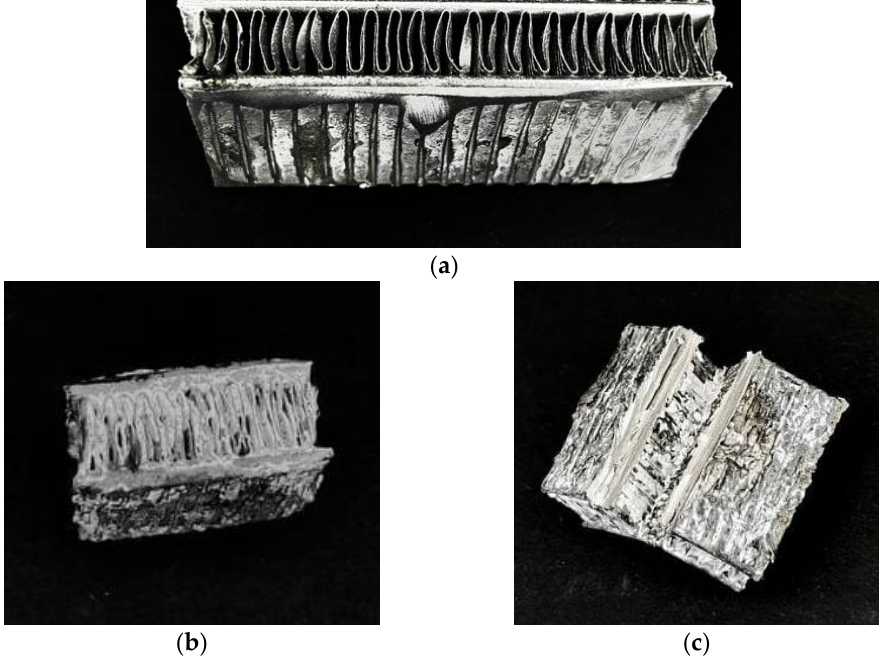
Figure 9. Photographs of part of ( a ) the uncovered aluminum heat exchanger; ( b ) the aluminum heat exchanger covered by SAPO-34 obtained via DGC, top view; ( c ) the aluminum heat exchanger covered by SAPO-34 obtained via SAC, dissected view.